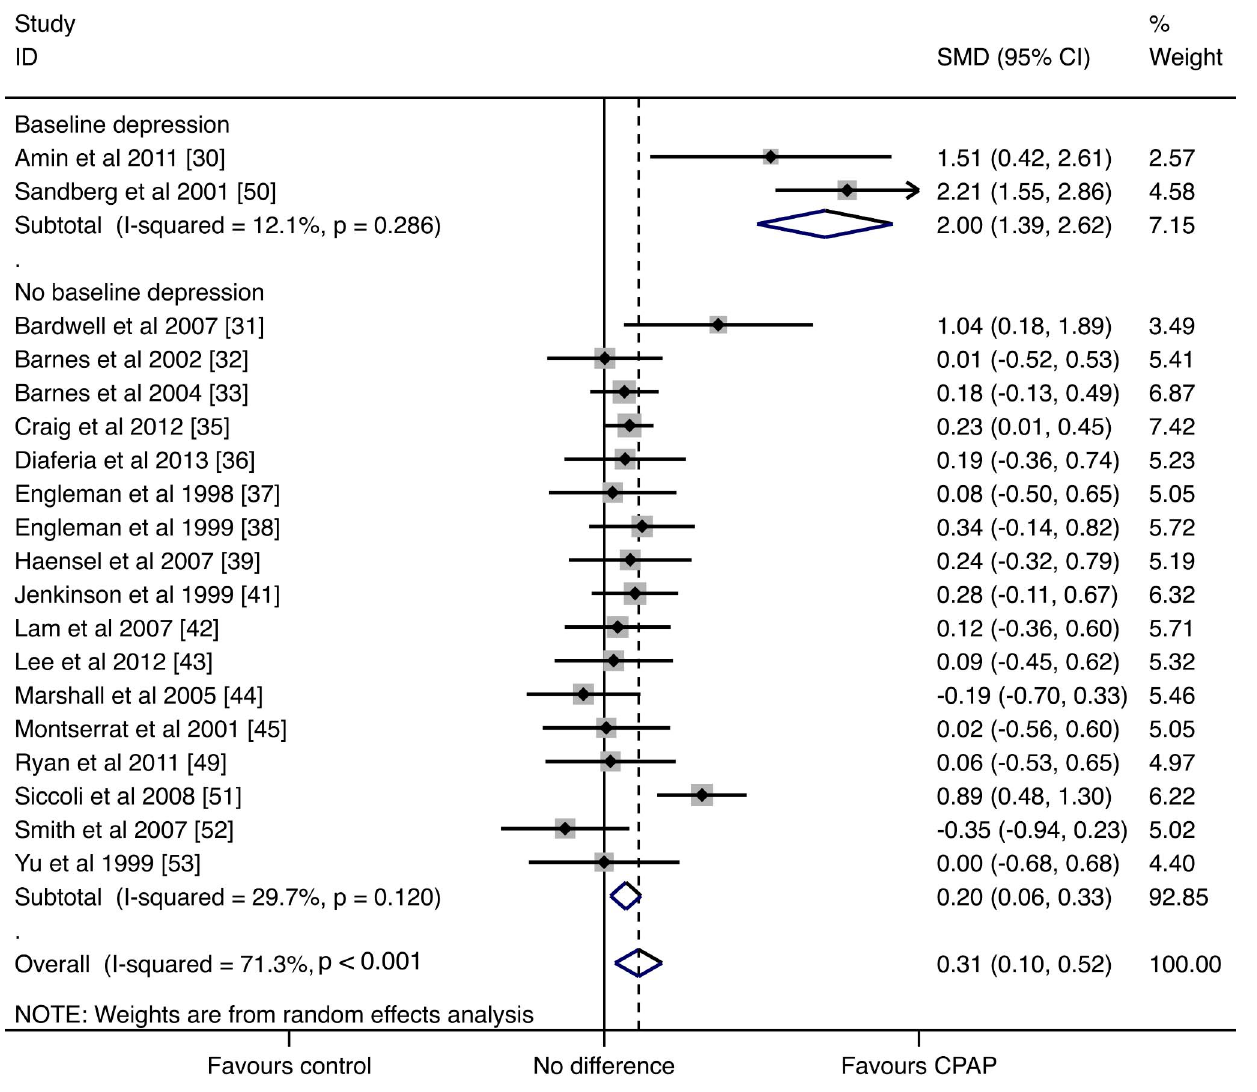
Figure 2. CPAP studies forest plot. Data were calculated by a random effects model. Studies were stratified by baseline depression score. Boxes are SMDs, and lines are 95% CIs. The vertical solid line represents no difference between CPAP and control. Values to the right of the solid line favor CPAP benefit. Pooled SMDs and 95% CIs are represented by the diamond shapes.